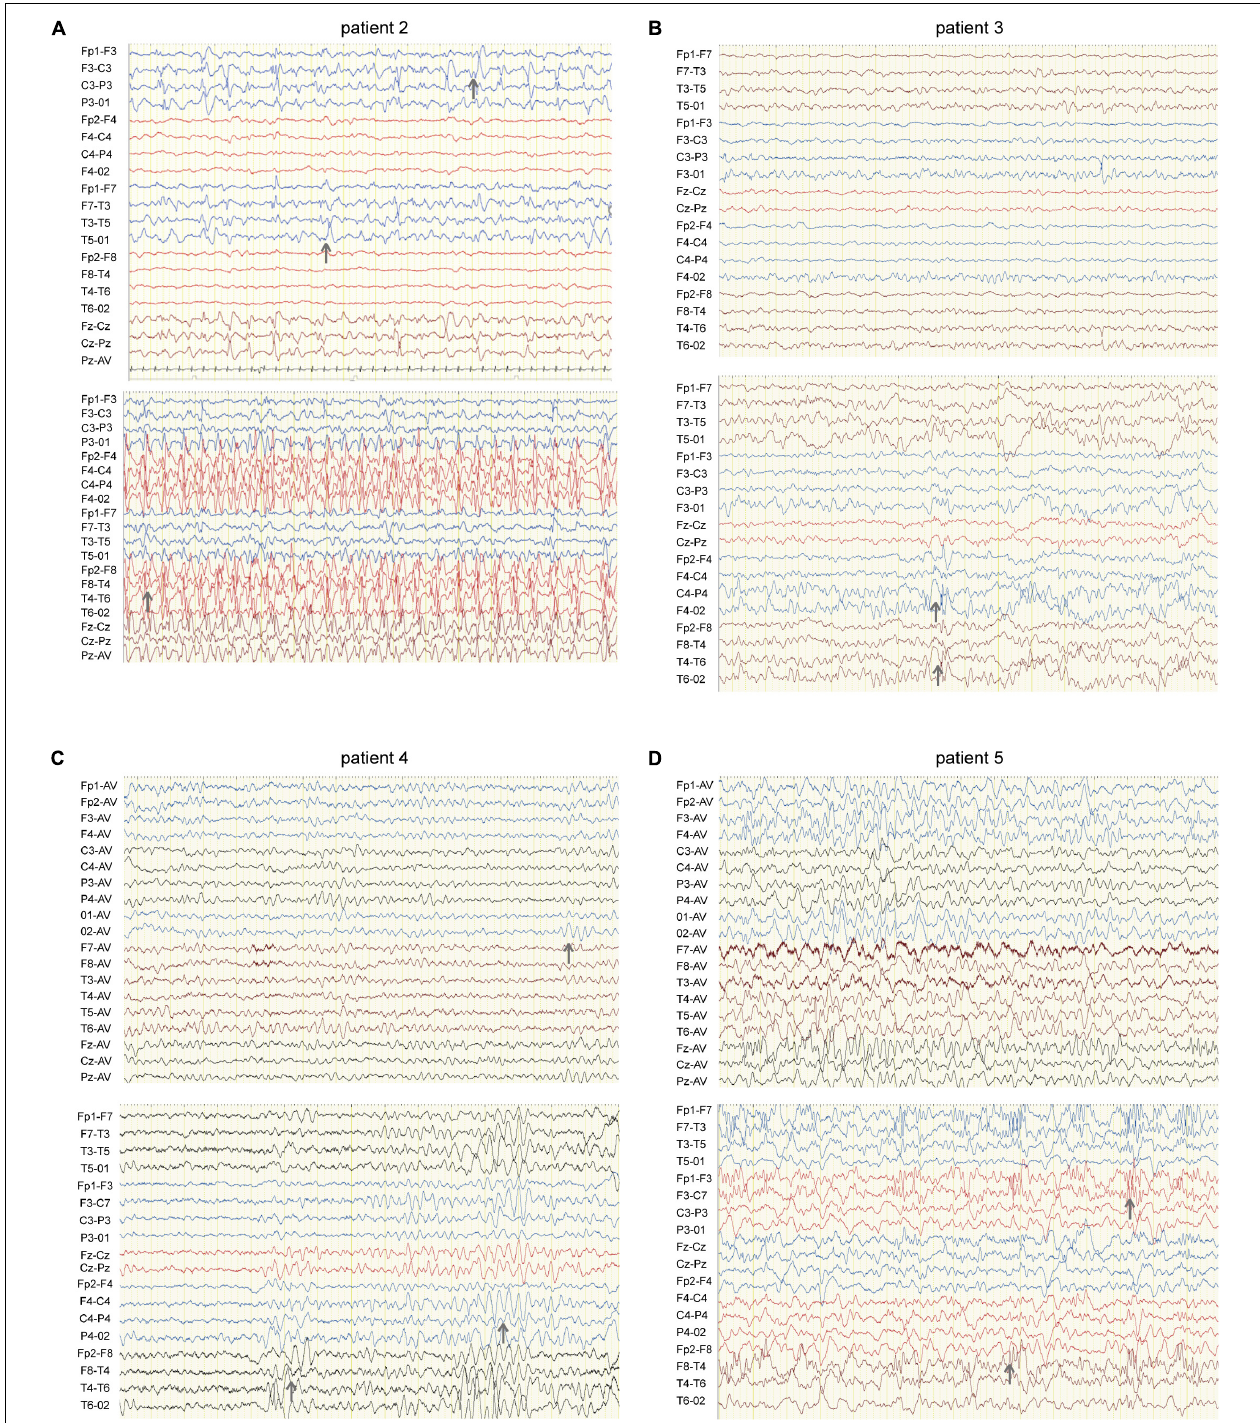
FIGURE 2 | EEG of four patients carrying HCN1 variants. (A) EEG of patient 2 (I380F) shows sharp waves in the left hemisphere during sleep (top) and spike waves during status epilepticus (bottom). Gray arrows indicate abnormal EEG waves. (B) EEG of patient 3 (A395G) shows sharp and sharp slow waves in the right occipital region during sleep (bottom). (C) EEG of patient 4 (S710Rfs*71) features a slow rhythm of background in the occipital region (top) and a paroxysm of diffused 4–5 Hz slow waves (bottom). (D) EEG of patient 5 (V572A) shows θ rhythm mixed δ waves in the background (top) and diffused 3.5–4 Hz multifocal spike-slow waves during a tonic-clonic seizure, while the patient was having a tonic-clonic seizure in sleep ( Figure 2D ) (bottom).